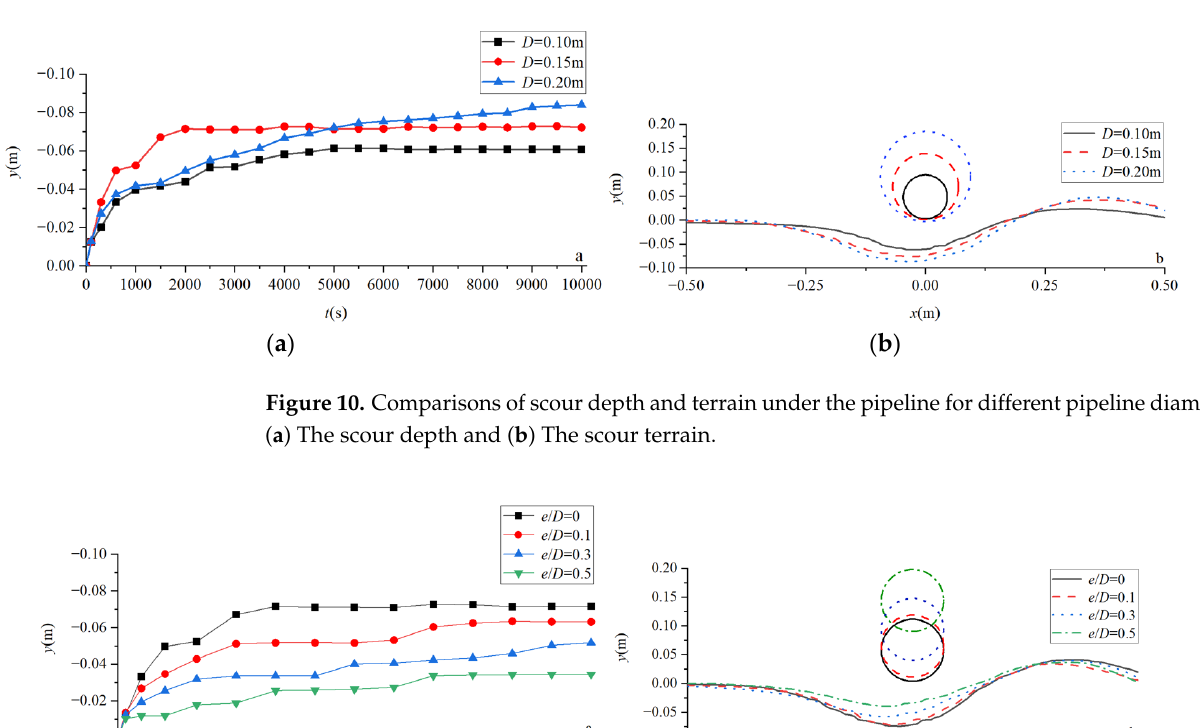
Figure 10. Comparisons of scour depth and terrain under the pipeline for different pipeline diame- ters. ( a ) The scour depth and ( b ) The scour terrain.